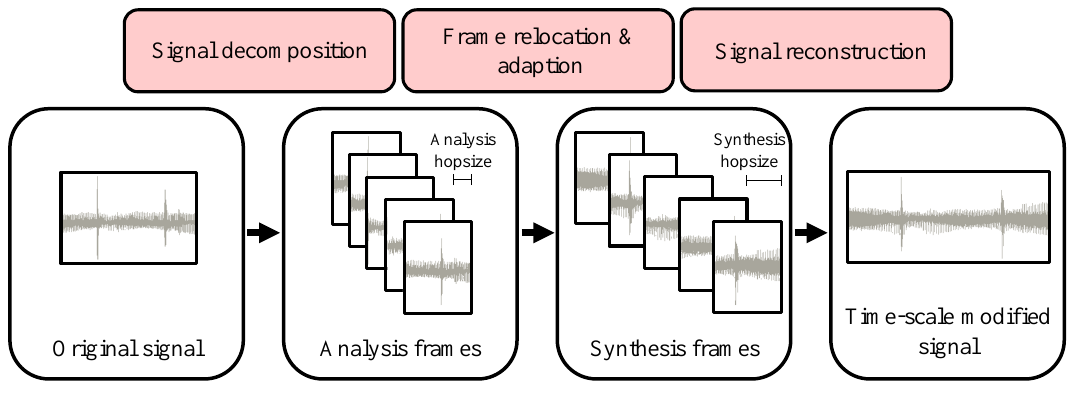
Figure 1. Generalized processing pipeline of Time-scale modification (TSM)